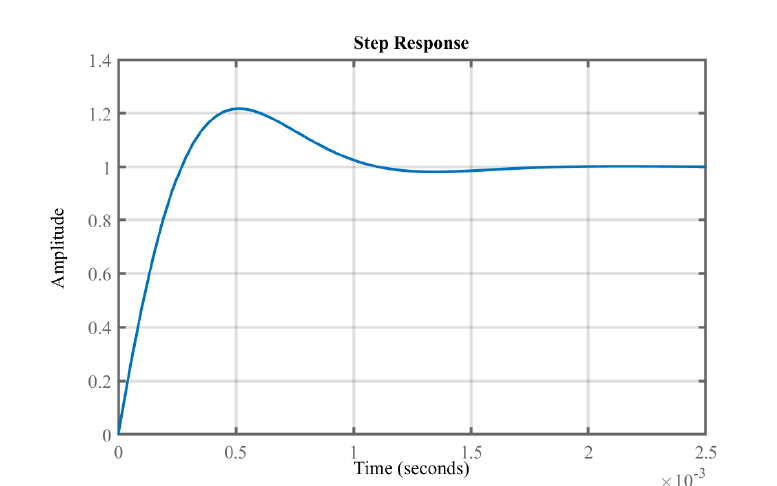
Figure 7. Step response of VSHP power consumption P AC to 1 W variation in P ref .